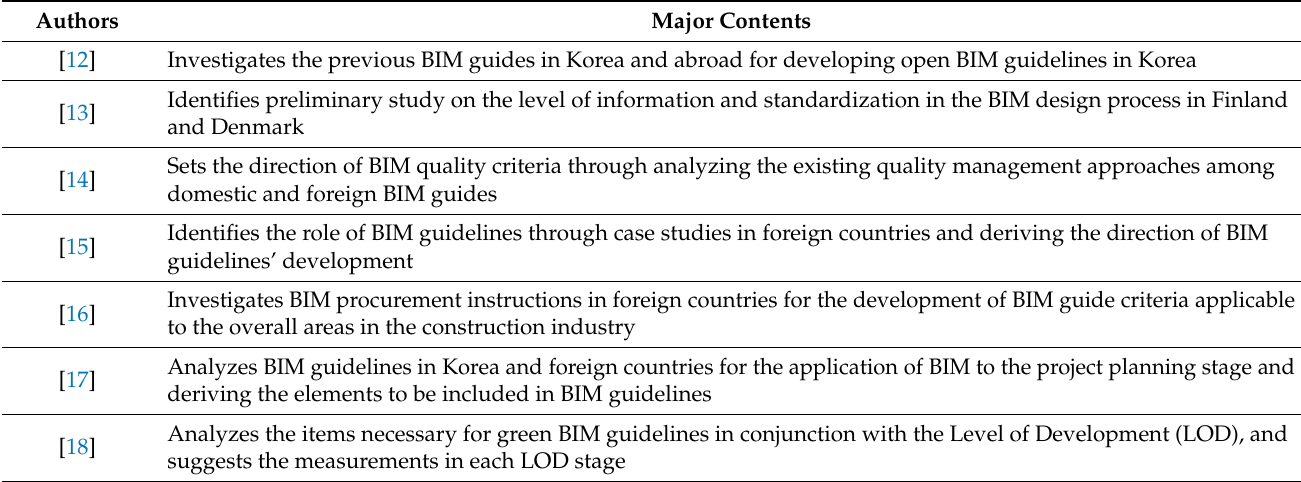
Table 1. Previous studies on BIM guides and